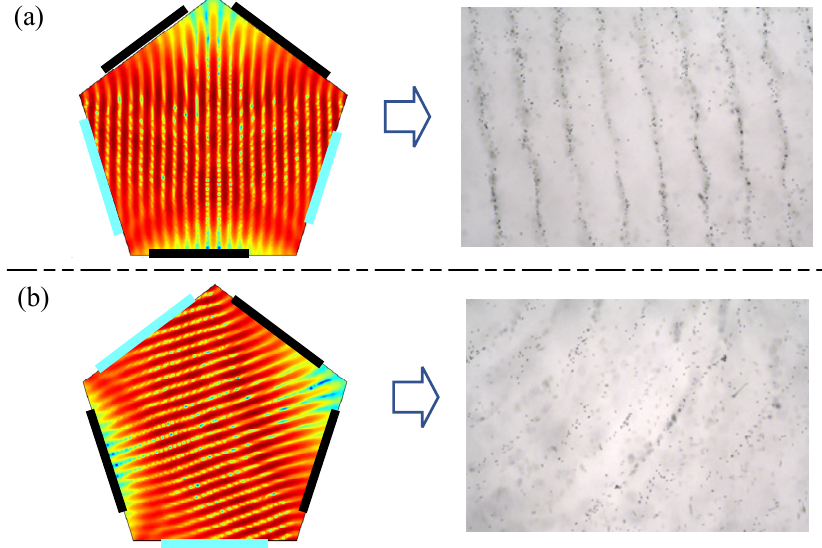
Figure 11. Double-layer manipulation of particles: ( a ) upper layer and ( b ) lower layer.